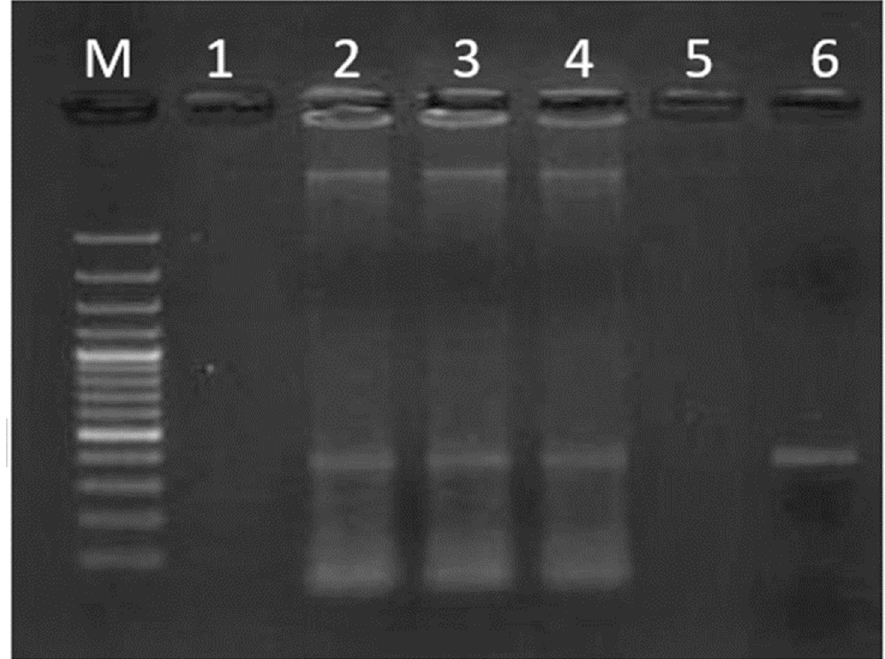
Figure 2. Example of a gel electrophoresis of the amplicons of vacA H. pylori gen generated by means of qPCR. M: Molecular weight marker (100 bp DNA Ladder); lane 1: sample V3, chard; lane 2: sample V20, lettuce; lane 3, sample V2, chard; lane 4, sample V12, spinach; lane 5, sample V6, lettuce; lane 6, positive control H. pylori NCTC 11638.